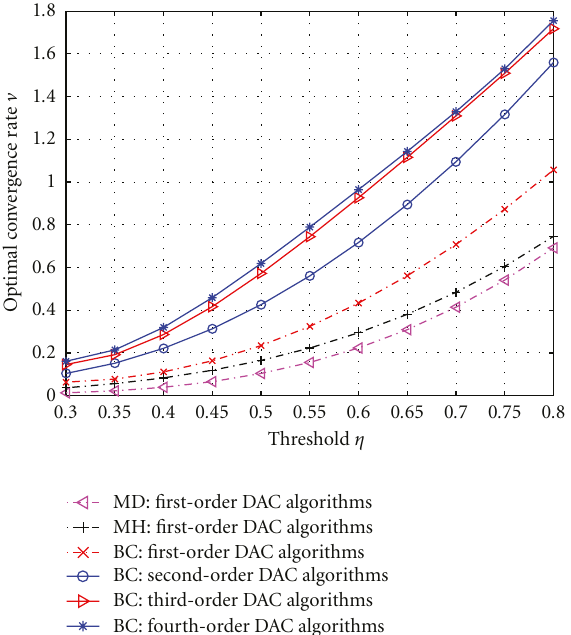
Figure 3: Convergence rate comparison of DAC algorithms with various weights in random networks versus distance threshold when N =